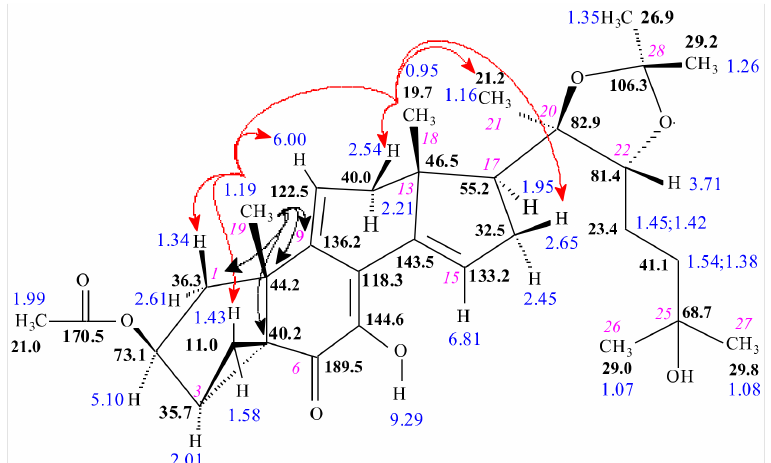
Figure 3. Stereostructure of compound 17 along with 1 H (blue) and 13 C NMR (black) chemical shifts. Cursive numbers denote the atomic numbering. The red arrows show spatial proximities determined by selNOE measurements and black arrows indicate characteristic HMBC responses.